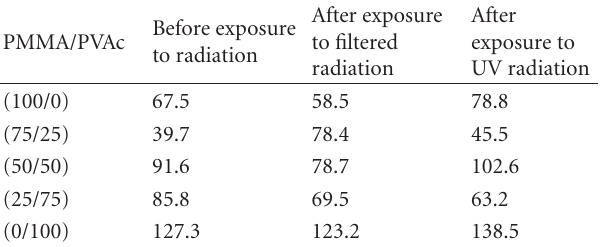
Table 3: Values of the constant B (cm − 1 eV 1 / 2 ) for di ff erent concentrations of PMMA/PVAc blend before and after exposure to UV and filtered radiation for 24 hours.